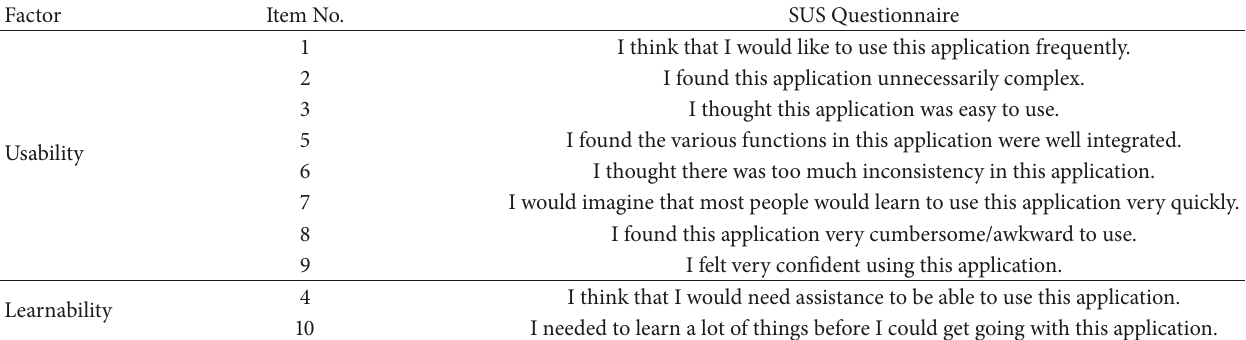
Table 3: SUS Questionnaire